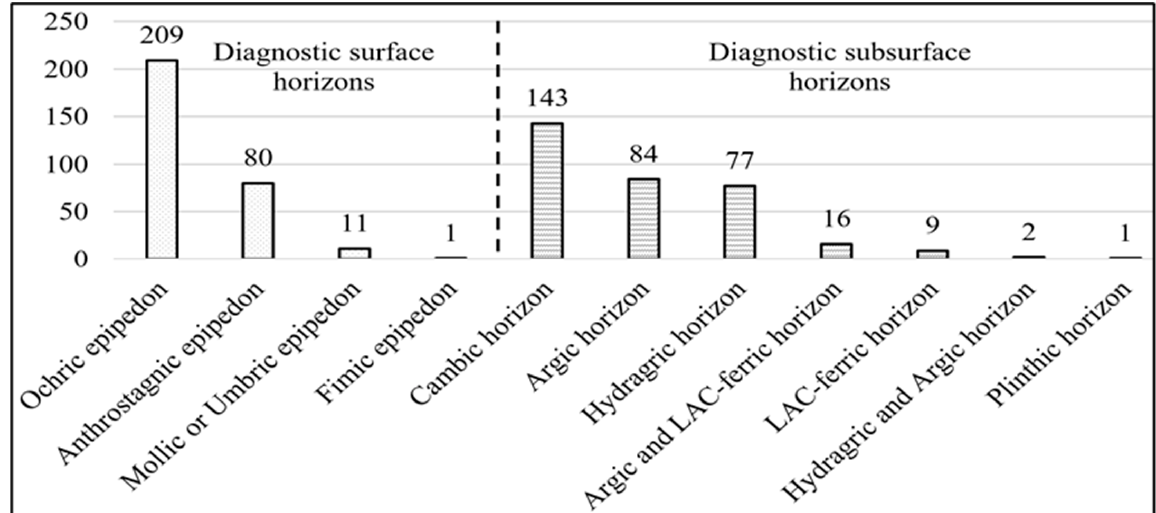
Figure 2. Distribution of the number of diagnostic horizons in soil profiles. In this study, Mollic epipedon (8 samples) and Umbric epipedon (3 samples) were combined into one type, labeled Mollic or Umbric epipedon, respectively, because of the small number of samples and the similarity of their properties. In addition, some diagnostic subsurface horizons are identified as both categories. This study chose to distinguish them as a separate horizons type (i.e., Argic and Low activity clay-ferric horizon (LAC-ferric horizon)) to be consistent with the results obtained in practice. That is, if the results obtained in practice are for both diagnostic horizons, then the diagnostic horizon identification model should also yield both results to prevent missing diagnostic